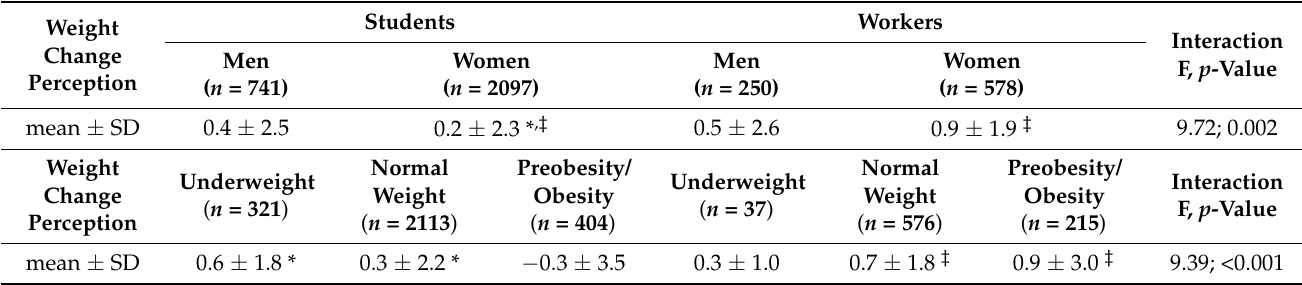
Table 2. Weight change perception divided by student/worker status and gender (first rows) and Body Mass Index (BMI) categories (last